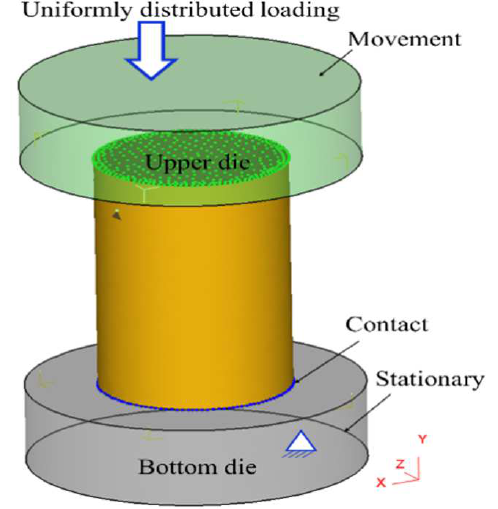
Figure 20. The FEM model for hot compression.